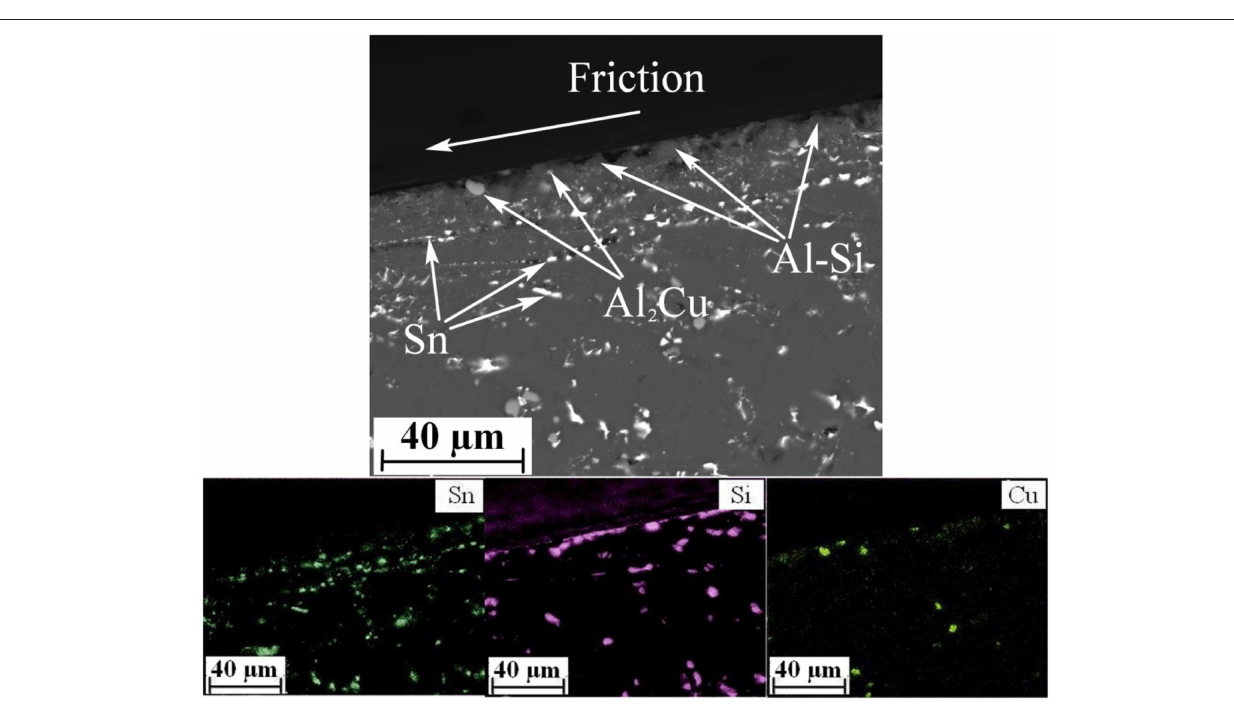
Frontiers in Mechanical Engineering |